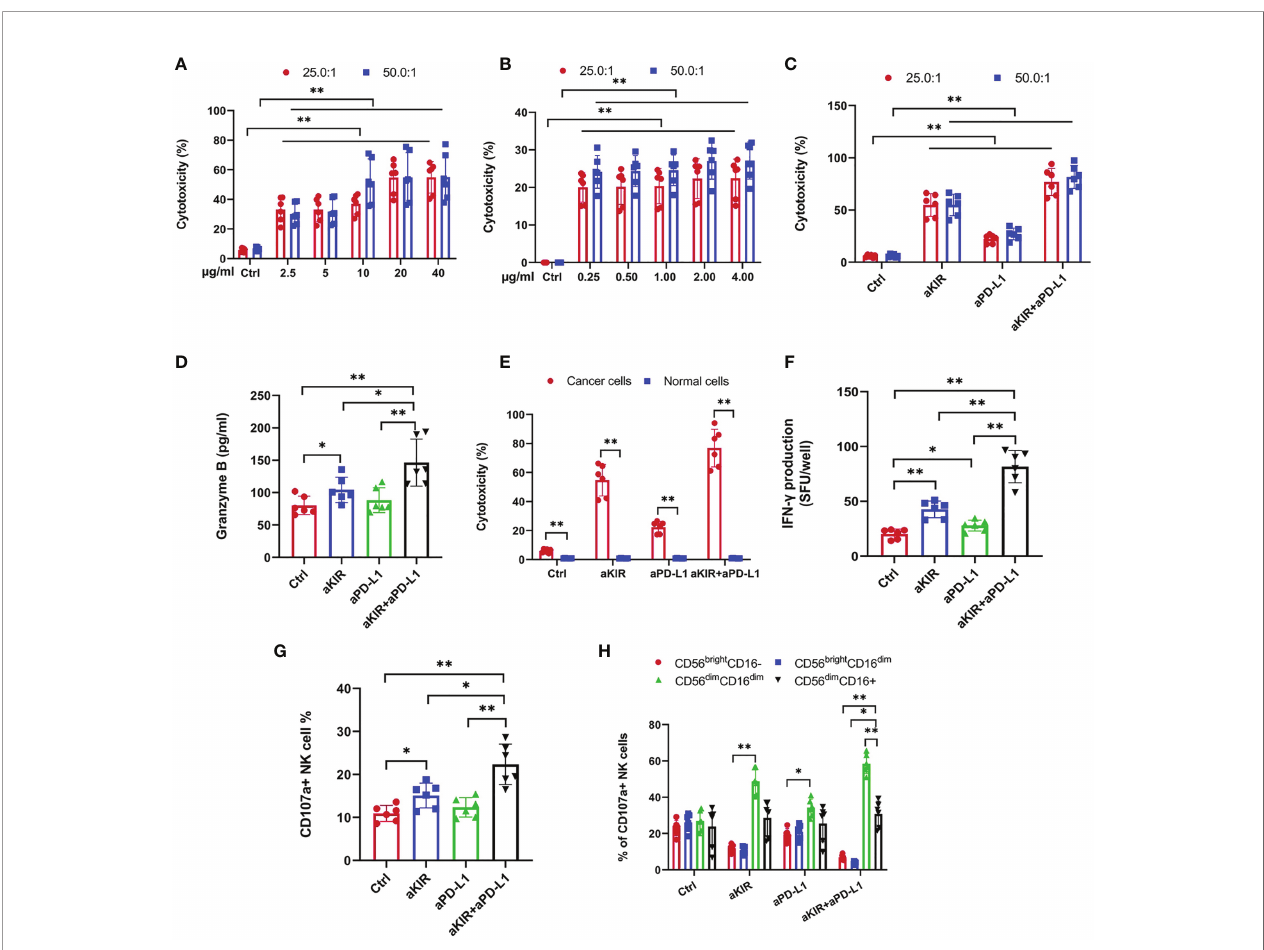
FIGURE 1 | Lirilumab and Avelumab Promote NK Cell Disinhibition and Cytotoxicity against HPV+ Cervical Cancer Cells in vitro . Blood-derived NK cells and autologous biopsy-derived malignant squamous cells obtained from HPV+ cervical cancer patients (n = 24) were incubated with DMSO (control), lirilumab (aKIR, 20 µg/ml) and/or avelumab (aPD-L1, 2.0 µg/ml), respectively, for 24 hours and then cultured together for 30 min. (A-C) NK cell-mediated lysis of cancer cells as measured by a target-based, europium-release cytotoxicity assay at E:T ratios of 25:1 and 50:1. (D) Blood-derived NK cells and autologous biopsy-derived malignant squamous cells or normal cervical squamous cells were incubated with control, aKIR, and/or aPD-L1 for 24 hours and then cultured together for 30 min for NK cell-mediated cytotoxicity assays. (E, F) NK cell (E) granzyme B and (F) IFN- g production as measured by the ELISPOT effector-cell-based assays. (G) Percentages of CD107a+ NK cells. (H) Percentages of CD56 dim CD16 dim and CD56 dim CD16+ CD107a+ NK cells. * P < 0.05, ** P < 0.01 [ (A – C) two-way ANOVA, (A, B) mAb concentration factor × E:T ratio factor, (C) mAb factor × E:T ratio factor, (D, F – H) one-way ANOVA, or (E) Student ’ s t -test]. n=3 biological replicates×3 technical